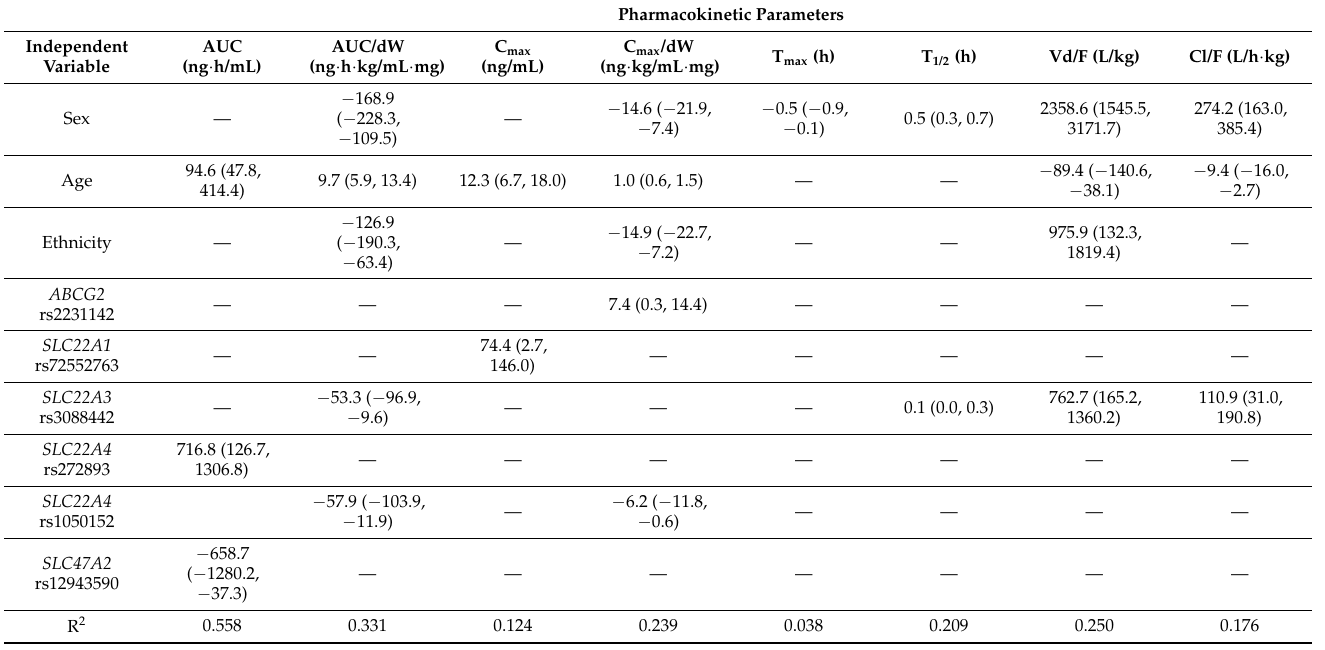
Table 4. Factors influencing metformin pharmacokinetic parameters. Results from the multivariate analysis. Pharmacokinetic